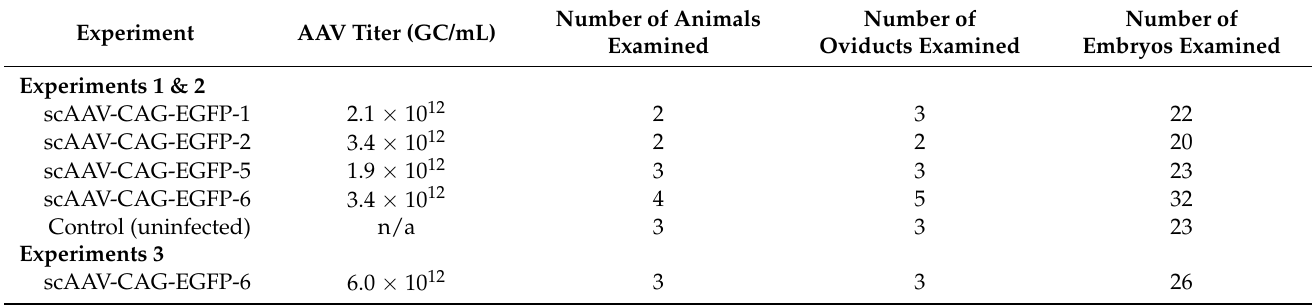
Table 1. Numbers of animals, embryos and viral titers used in this